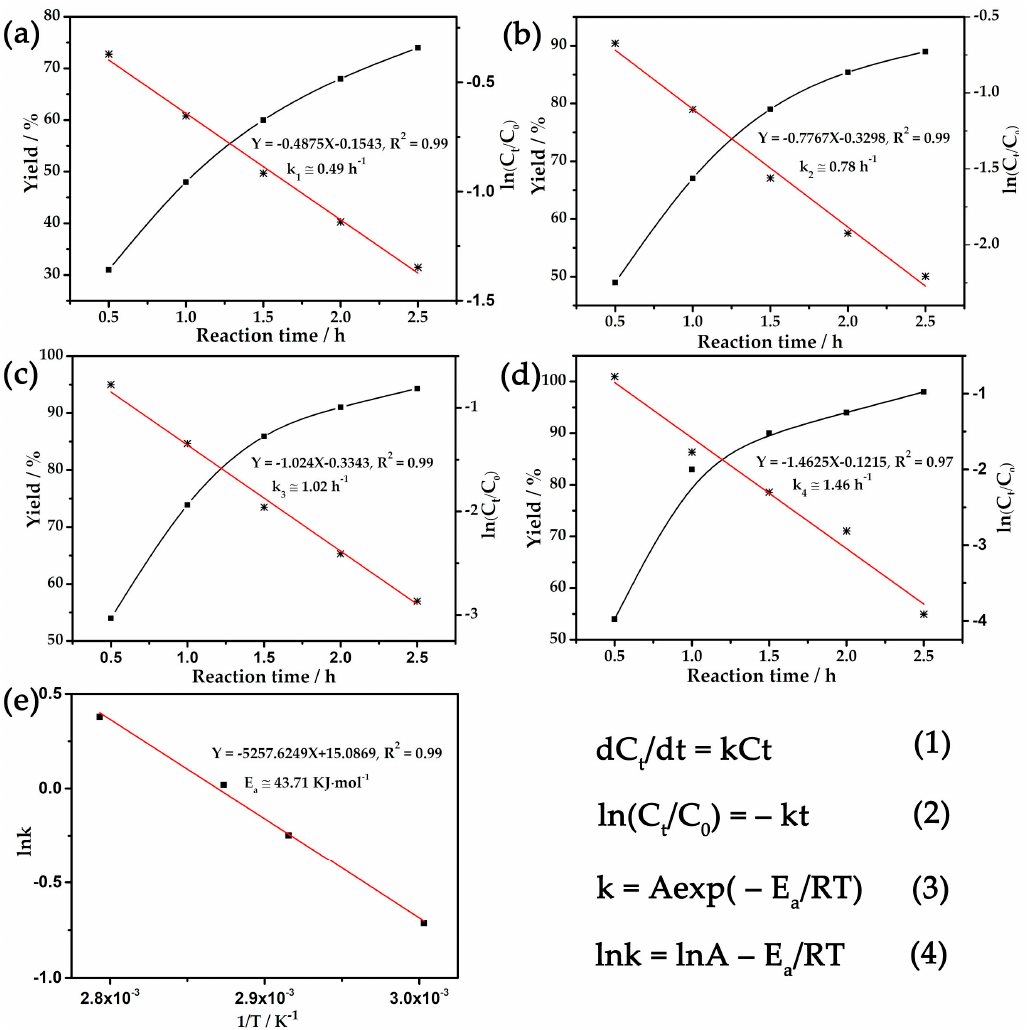
Figure 2. Kinetics for 1-phenylethanol oxidation reaction using catalyst 1 at ( a ) 60, ( b ) 70, ( c ) 75 and ( d ) 85 °C for 3 h, respectively. The data from each reaction temperature are fitted to a single straight line, indicating the reaction was pseudo-first-order in 1-phenylethanol. ( e ) Arrhenius plot for the oxidation of 1-phenylethanol using catalyst 1 at 60, 70, 75 and 85 °C for 3 h. C 0 and C t represent the concentrations of reactant initially and at time t, respectively.